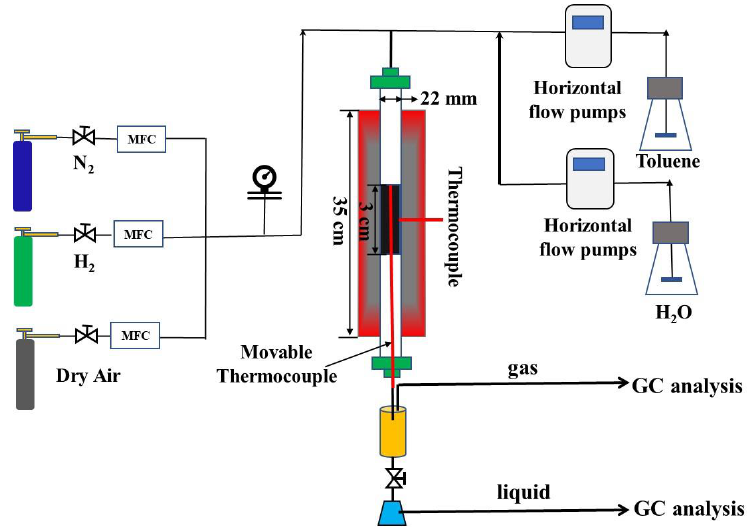
11 of 15 Figure 7. Theoretical efficiency calculation of autothermal reforming and external heating reforming at different temperatures ( a ), different O 2 /C molar ratios ( b ), and different S/C molar ratios ( c ). 3. Experiment and